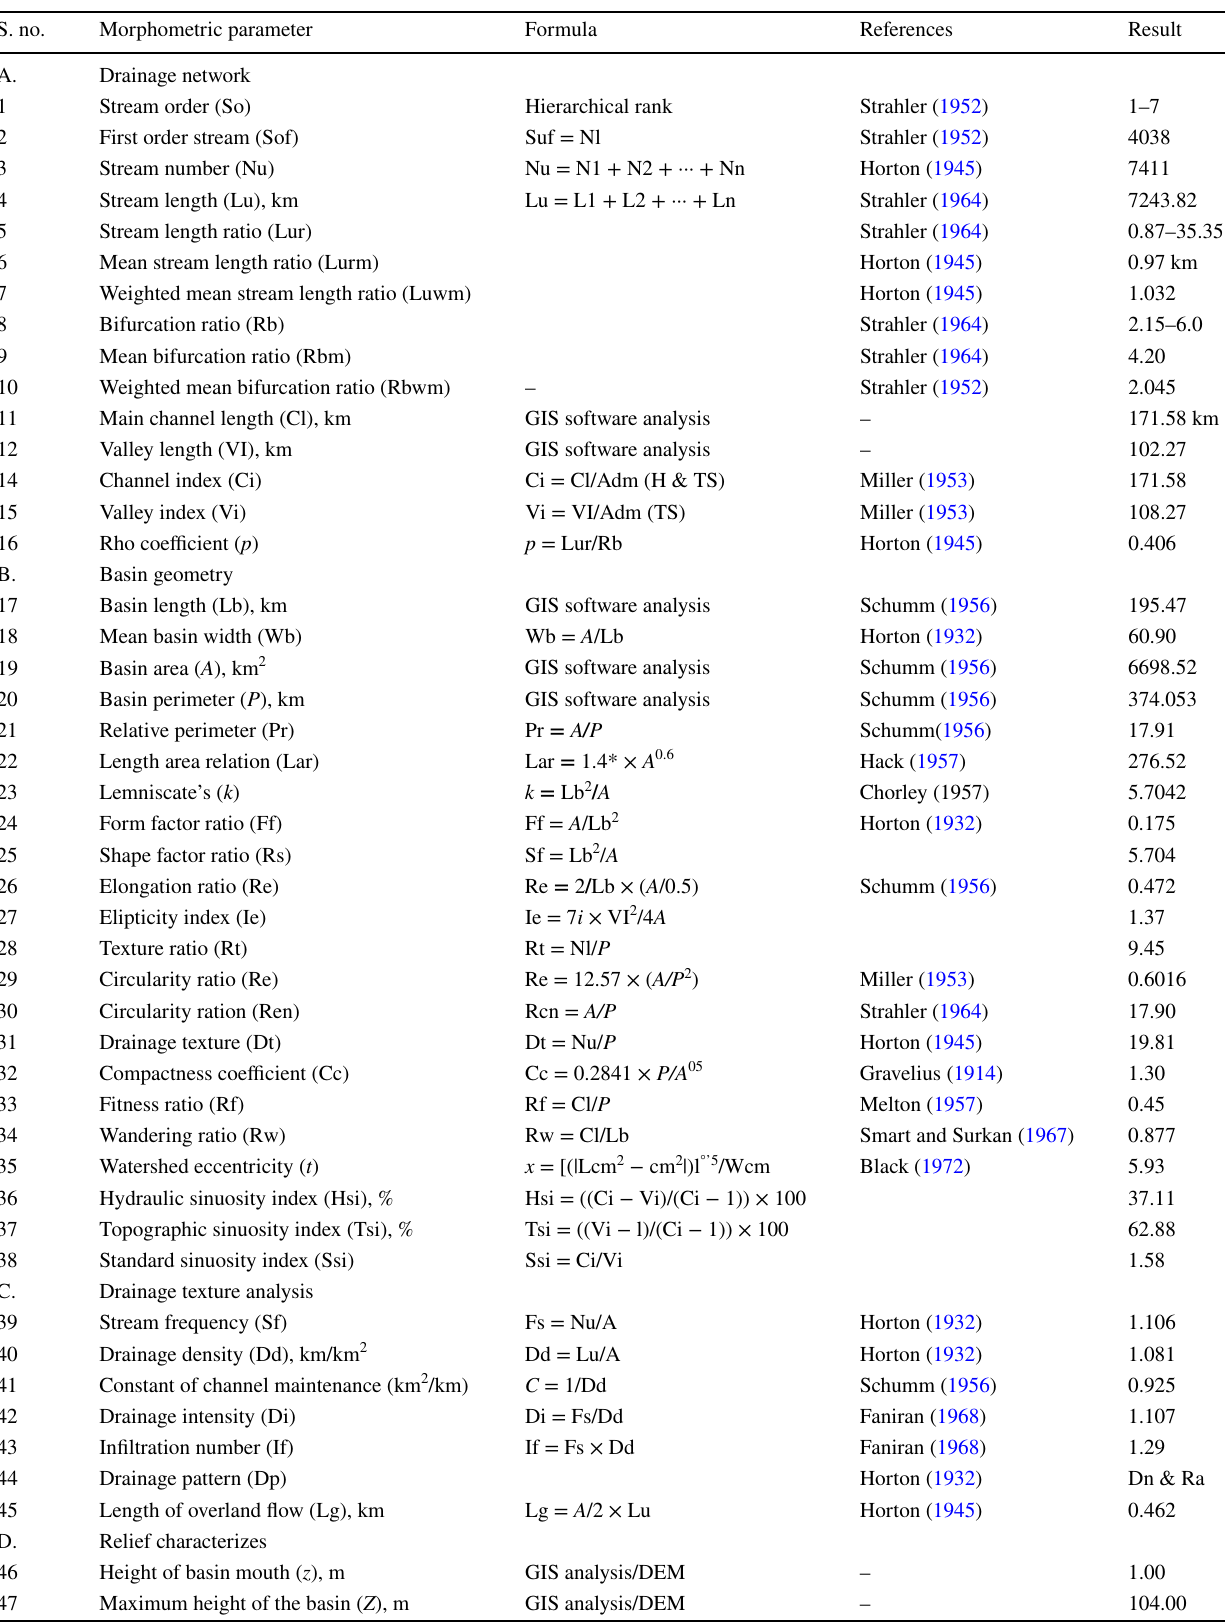
Table 1 Morphometric analysis of Kosi basin—a comparative characteristic S.